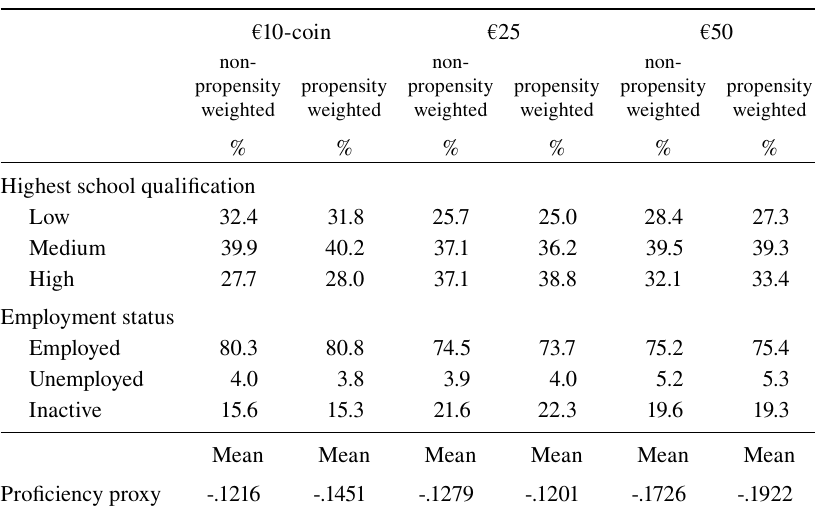
Table 5 Comparison of survey estimates for non-propensity and propensity weighted data across incentive treatments €10-coin €25 €50 non-